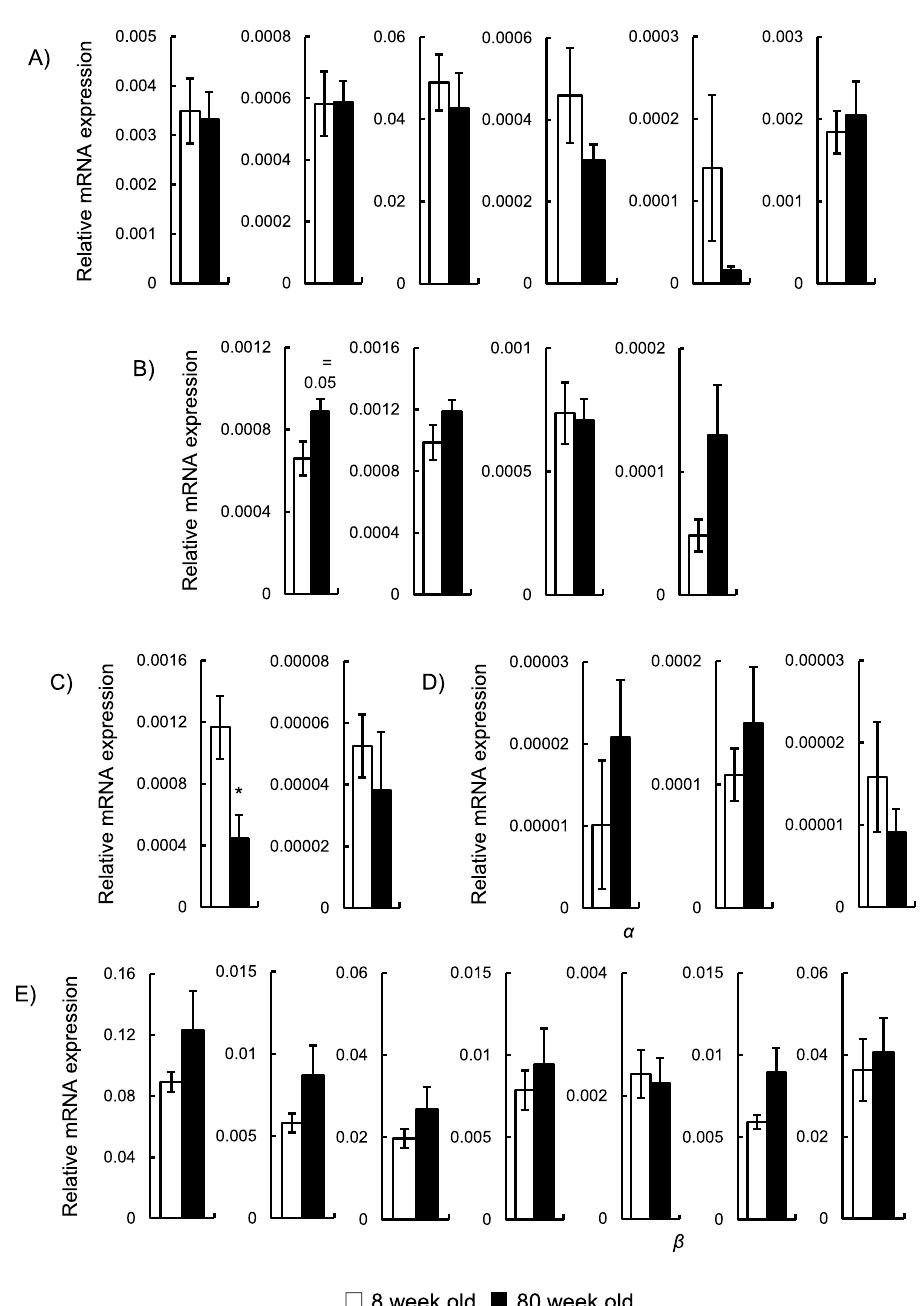
Fig 4. Comparison of mRNA expression in the hippocampus. Quantitative mRNA expression for (A) nerve growth factor, (B) NADPH oxidase, (C) nitric oxide synthase, (D) inflammatory, and (E) long-term memory store-related genes of 8-week-old (white column, n = 6) and 80-week-old mice (gray column, n = 6). � p > 0.05 (Welch’s t -test).